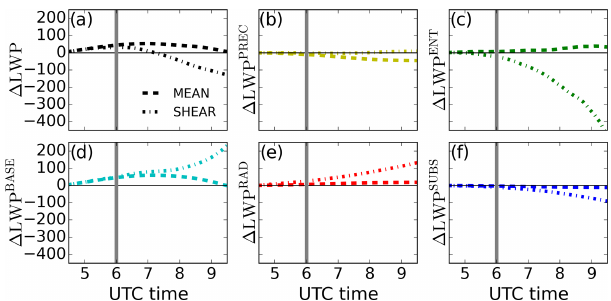
Figure 7. Time series of accumulated differences between MEAN and REF (dashed) and between SHEAR and REF (dotted–dashed) for each term defined in Eq. (2) and calculated following Eq.